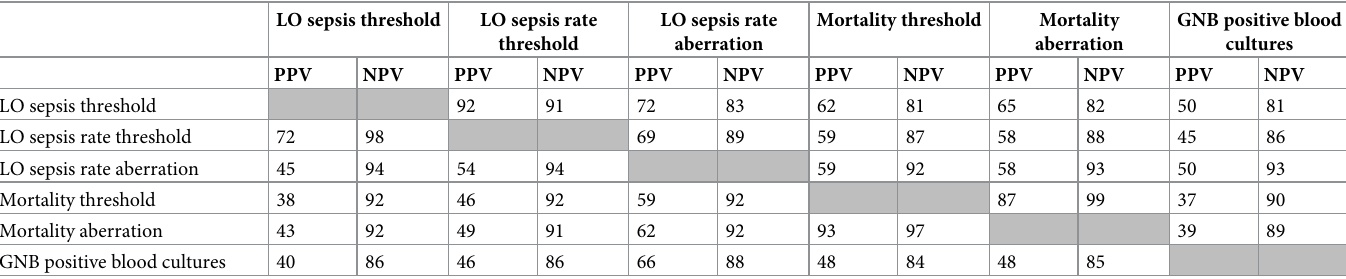
Table 5. Positive predictive value and negative predictive value for pairs of alarm